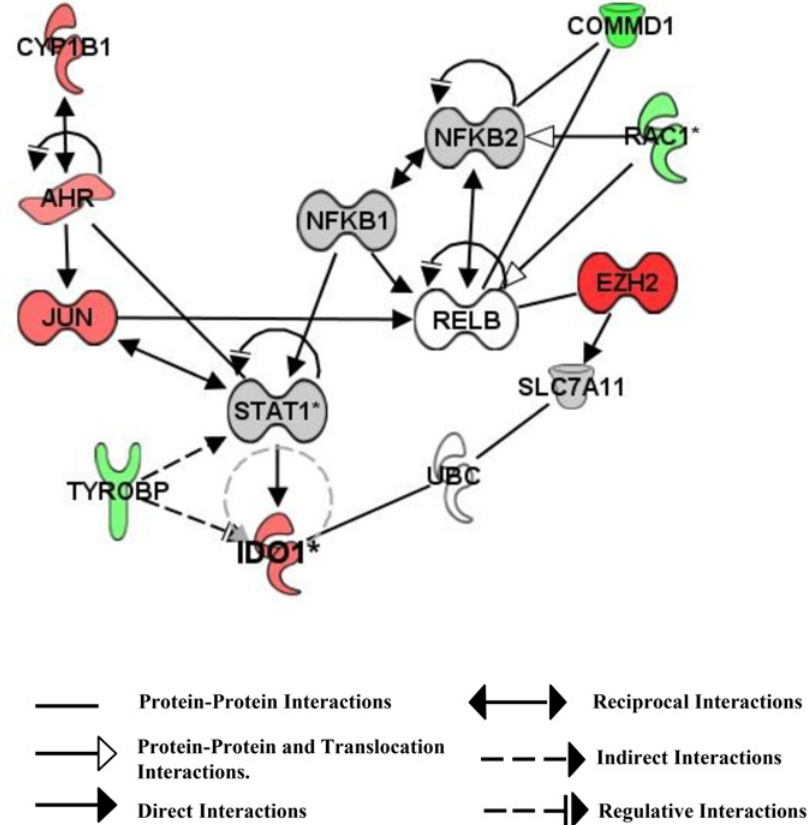
Fig 5. Diagram of upstream signals that regulate IDO1 biosynthesis in CTB-INS vaccinated human DCs. Signaling pathways involved in vaccine up-regulation of IDO1 biosynthesis in human DCs were identified by Ingenuity Pathway analysis of proteins detected in vaccinated DCs by mass spectrometer analysis. (Red: up-regulation of the protein, Green: down-regulation of the protein, Grey: protein levels unchanged, White: Undetected). Based on calculations generated from the mass spectrometry data, the IPA program indicates the vaccine up-regulates the aryl hydrocarbon receptor (AhR) signal transduction pathways and down regulates TYROBP to increase IDO biosynthesis. NF- κ B1 : is the P105 precursor subunit of NF- κ B which is cleaved to generate the P50 subunit of the canonical NF- κ B transcriptional activator protein, located in the cytoplasm. NF- κ B2 : is the P100 subunit of non-canonical NF- κ B, cleaved to generate the p52 subunit, located in the